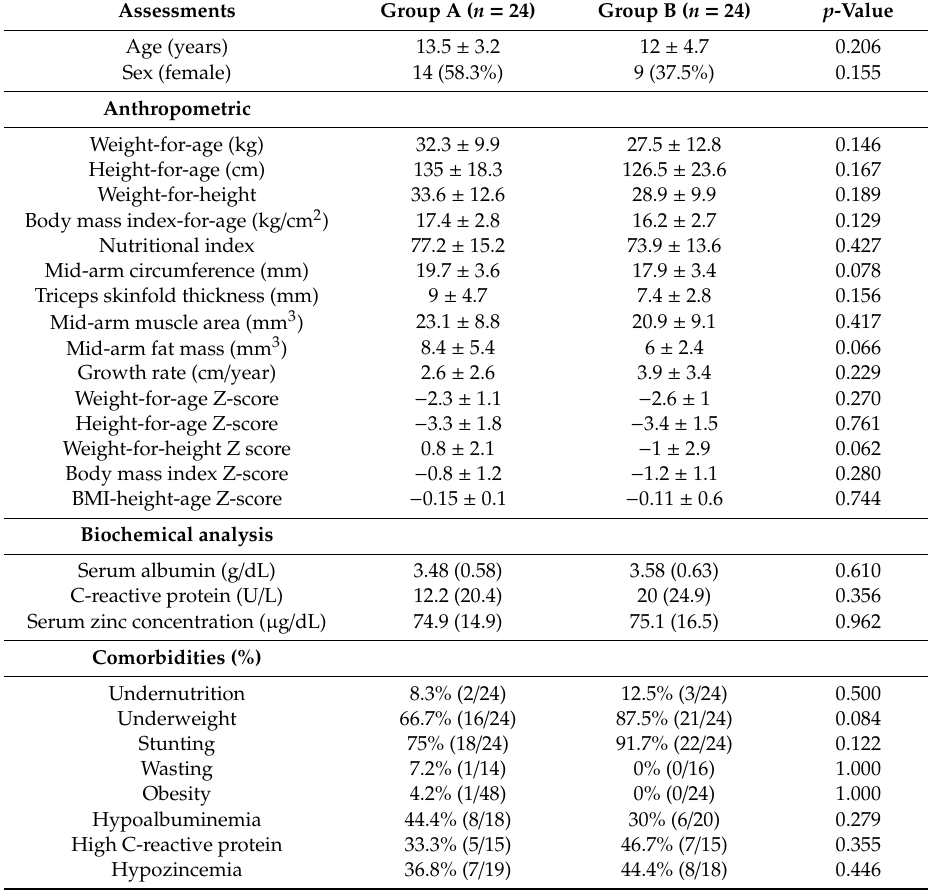
Table 1. The characteristics of kidney disease patients at the start by groups of treatment (day 0, n = 48).